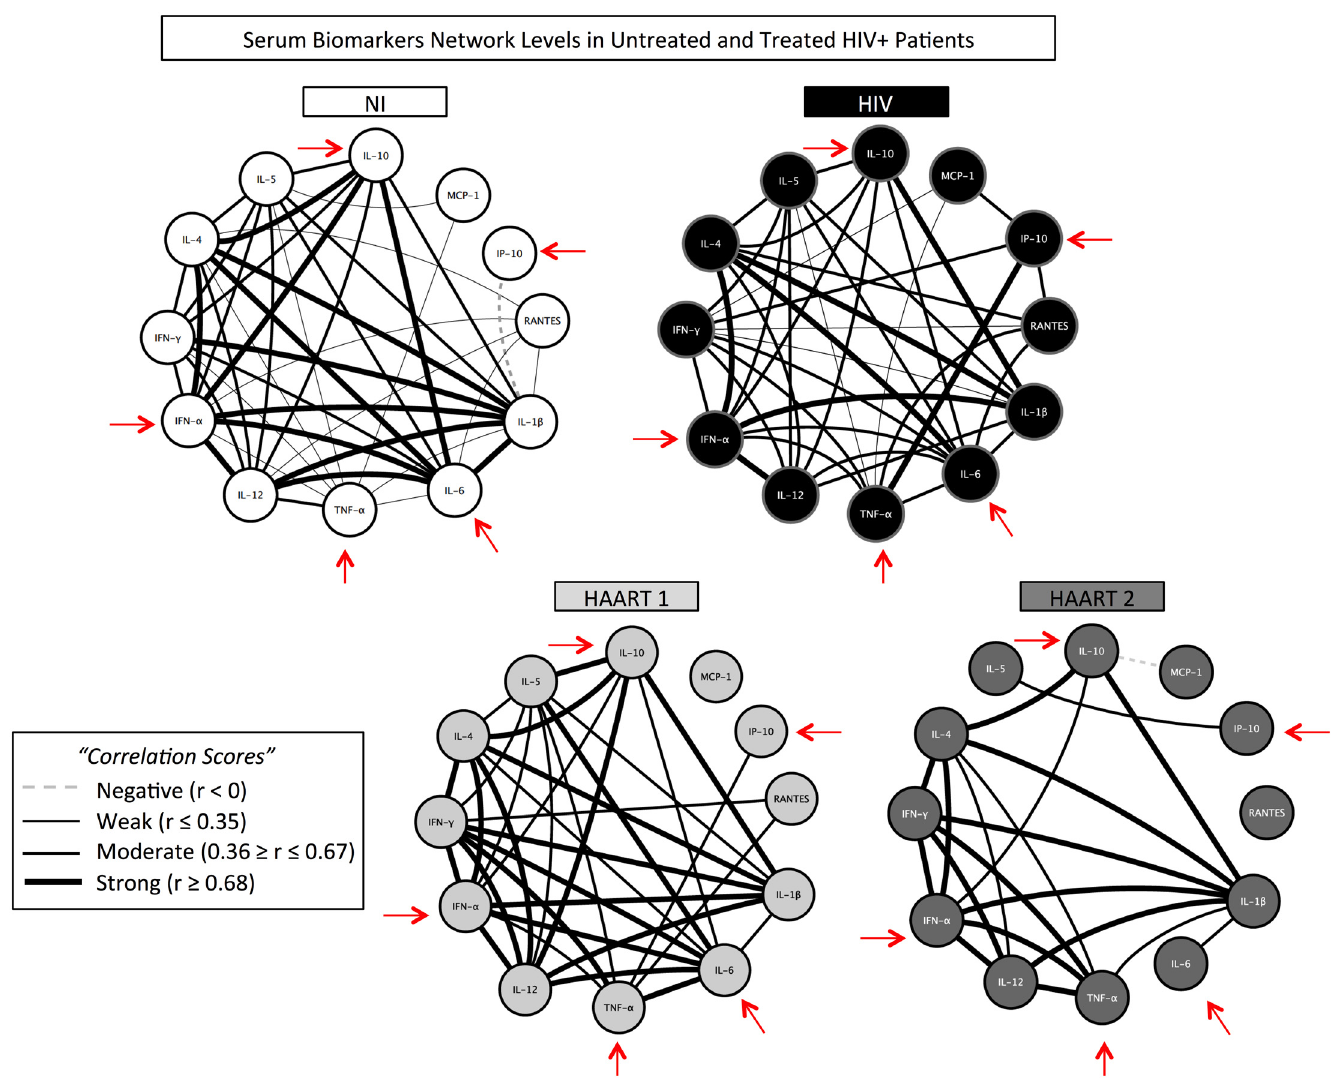
Fig 4. Systemic interaction of immunological biomarkers is modified in the course of HIV disease and according to treatment regimen. The network analysis shows significant correlations (p < 0.05) among all the variables, which were measured after calculation of Spearman correlation for each pair of biomarkers, and are represented by lines for NI, HIV, HAART 1, and HAART 2 groups. The strength of the correlation was given by “ r ” value and is illustrated as negative (r < 0), weak (r (cid:1) 0.35); moderate (0.36 (cid:1) r (cid:1) 0.67); or strong (r (cid:3) 0.68). Arrows indicate the main biomarkers modified during HIV infection.